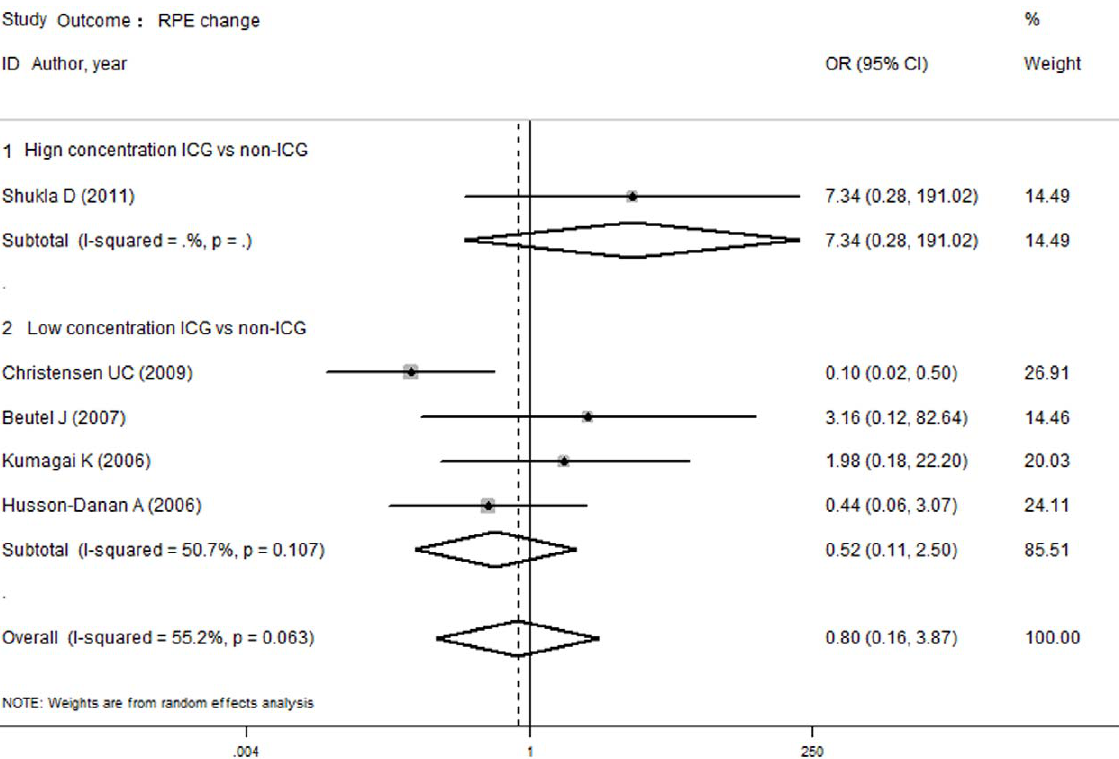
Figure 6. Subgroup analyses of outcome RPE change in ICG group versus unstained and other stains groups. There were no differences in the risk of RPE changes between the ICG group and the unstained or other stains groups.